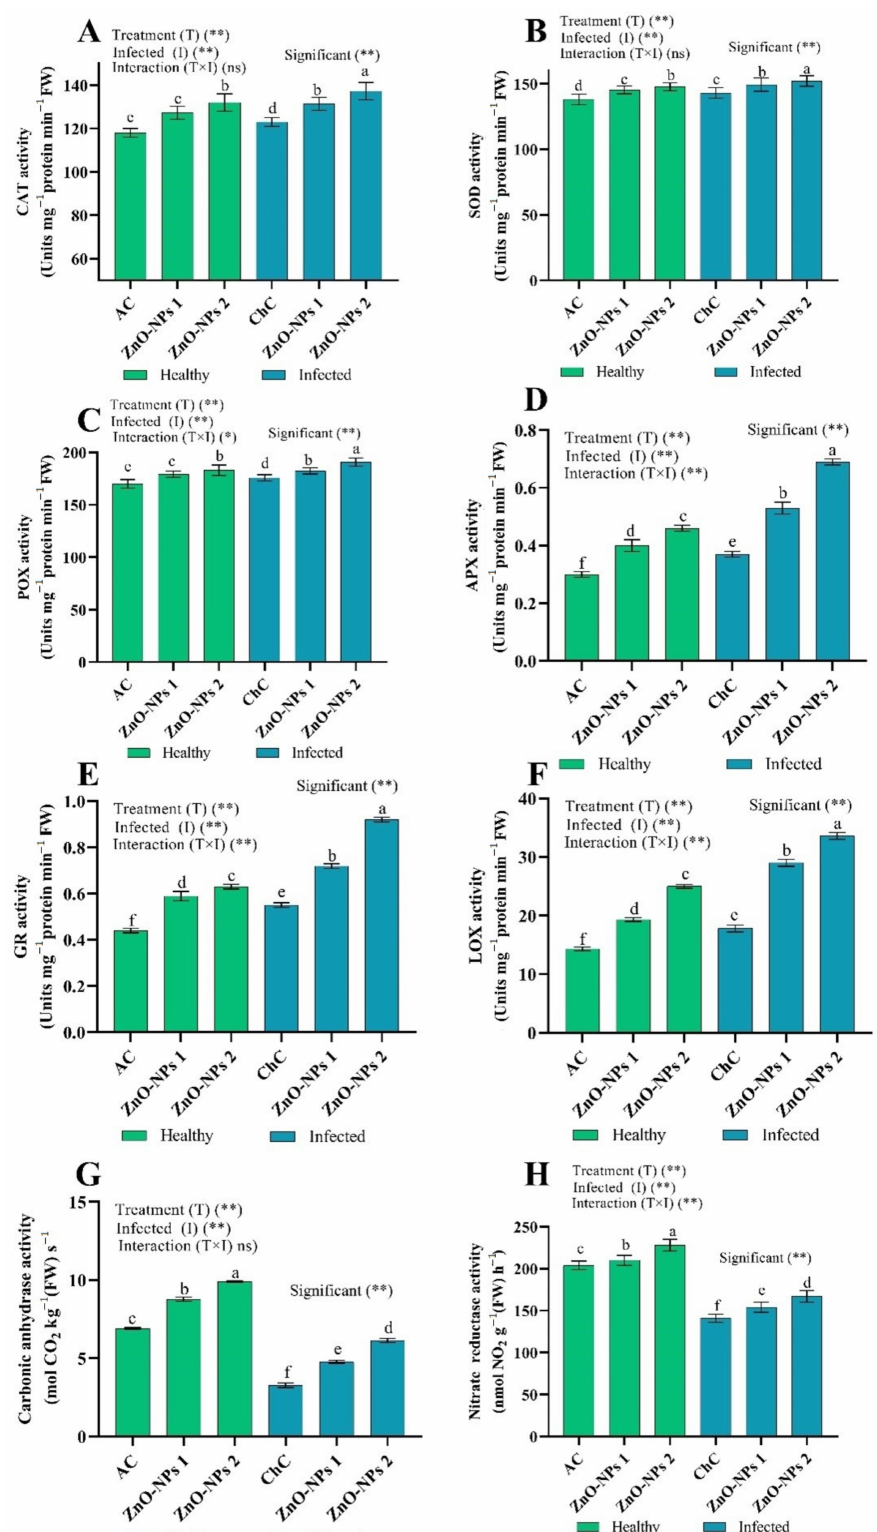
Figure 7. ( A – H ) Effect of foliar spray by ZnO-NPs1 (50 mg/L) and ZnO-NPs (100 mg/L) on ROS scavenging enzymes under absolute control (AC) and Tomato mosaic virus (ToMV) infection (ChC). According to the Fisher test, the different letters (a, b, c, d, e, f) are significantly different at 0.05%. Vertical bars represent the means of three independent determinations ± standard error (SE). * and ** suggest significant and highly significant differences. ns = not